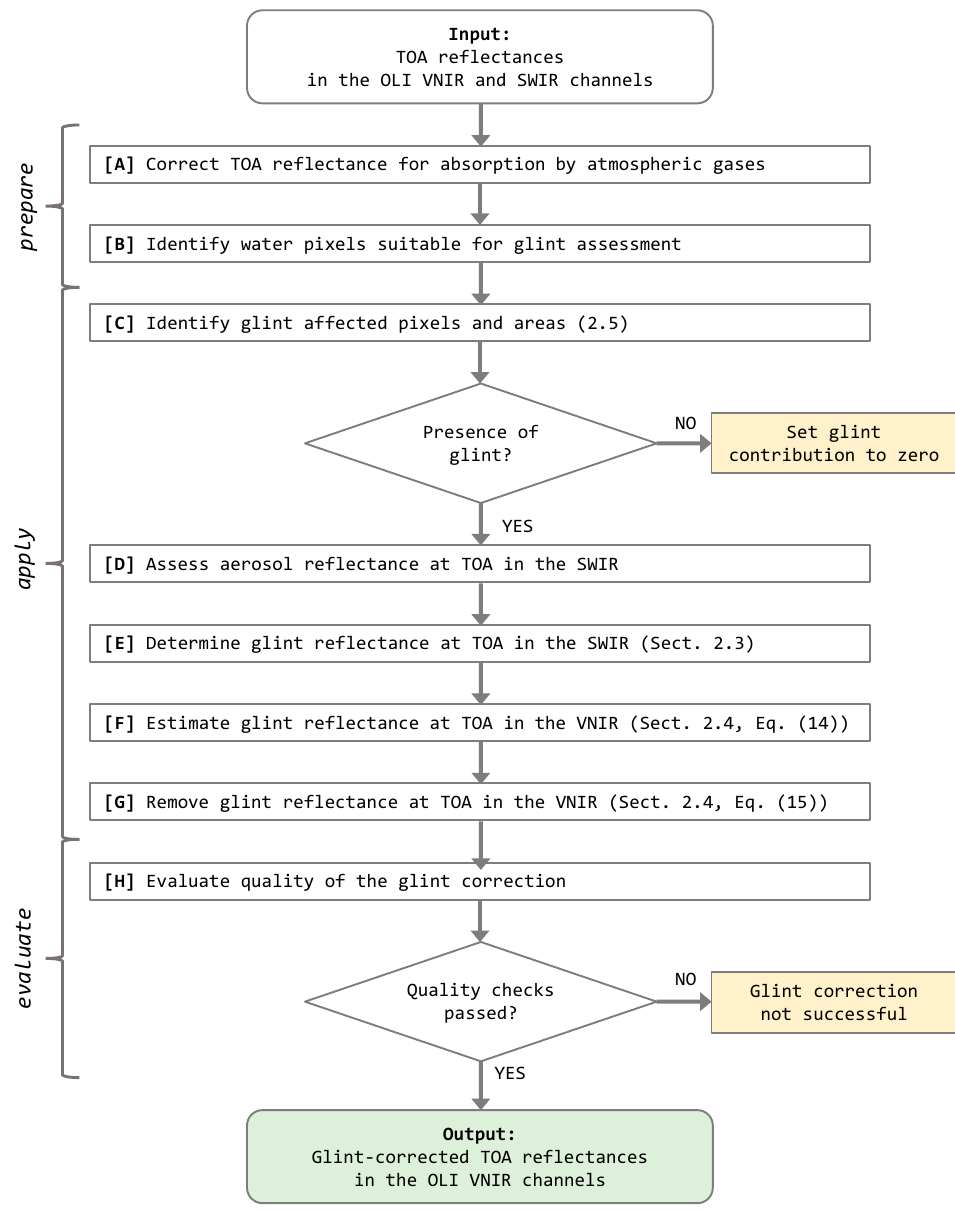
Figure 4. Flow chart of the GRCM sun glint correction scheme.